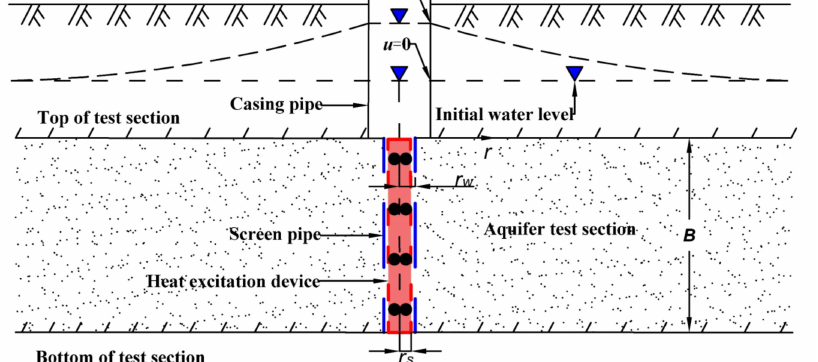
Figure 1. Schematic diagram of the slug heat test model (The blue dashed line represents the outer wall of the screen pipe, and the red dashed line represents the outer wall of heat excitation device. Red area represents the internal structure of the heat excitation